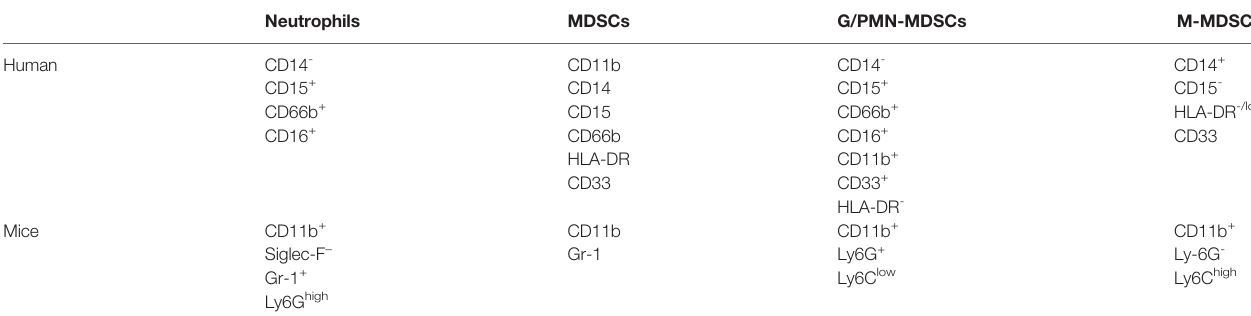
TABLE 1 | Markers of neutrophils and